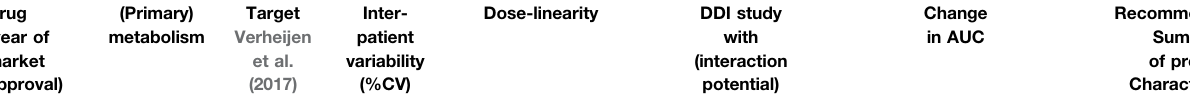
TABLE 2 | ( Continued ) Detailed overview of the results of DDI studies performed with the reviewed oral oncolytic